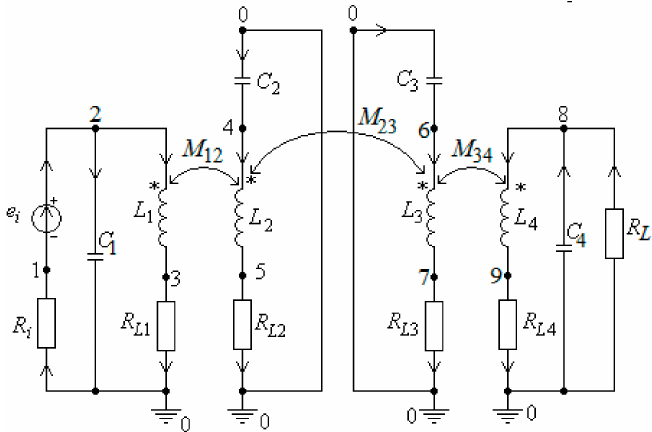
Figure 2. A 4-coil WPTS, with circuits 2 and 3 series. Increasing the number of magnetic couplings of the resonant